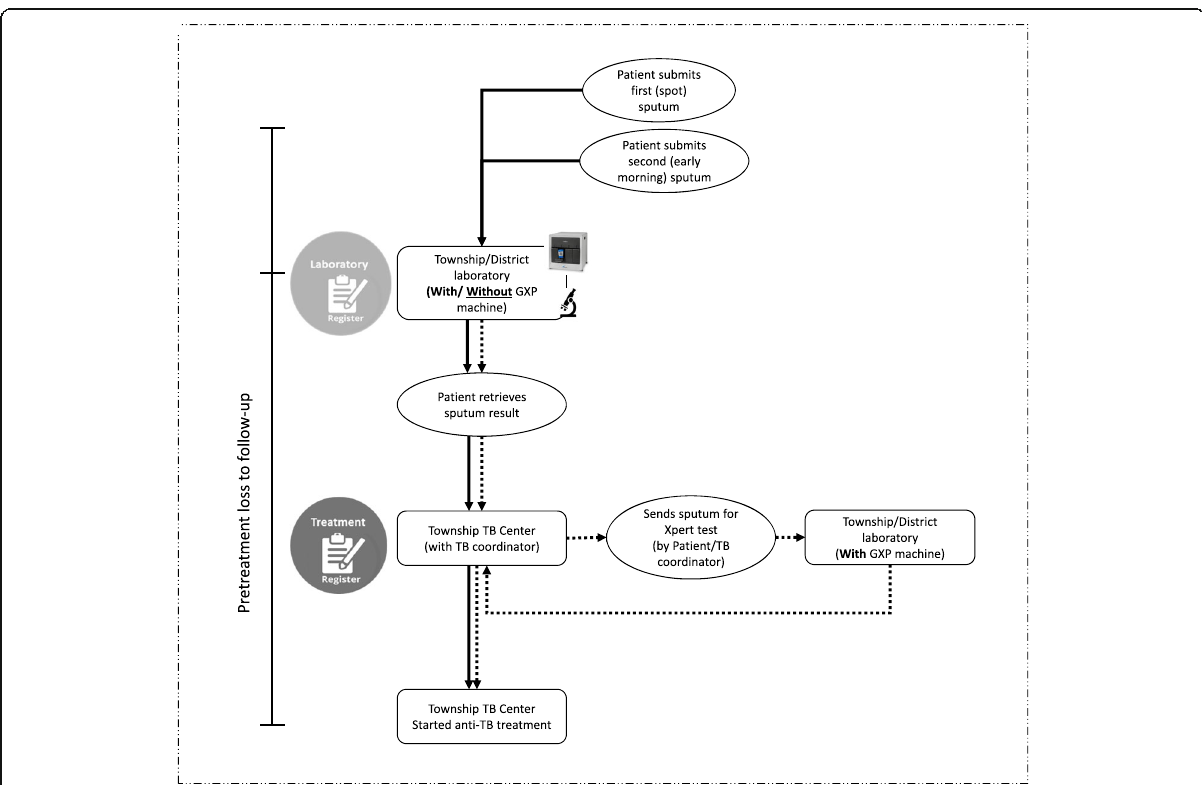
Fig. 1 The process of diagnosis and linkage to care for bacteriologically confirmed tuberculosis patients in Myanmar between January and June 2017. TB, tuberculosis; GXP, Gene Xpert machine; Xpert test, Xpert® MTB/RIF assay; solid line, the process if the sputum smear was tested at facility with GXP machine; dotted line, the process if the sputum smear was tested at facility without GXP